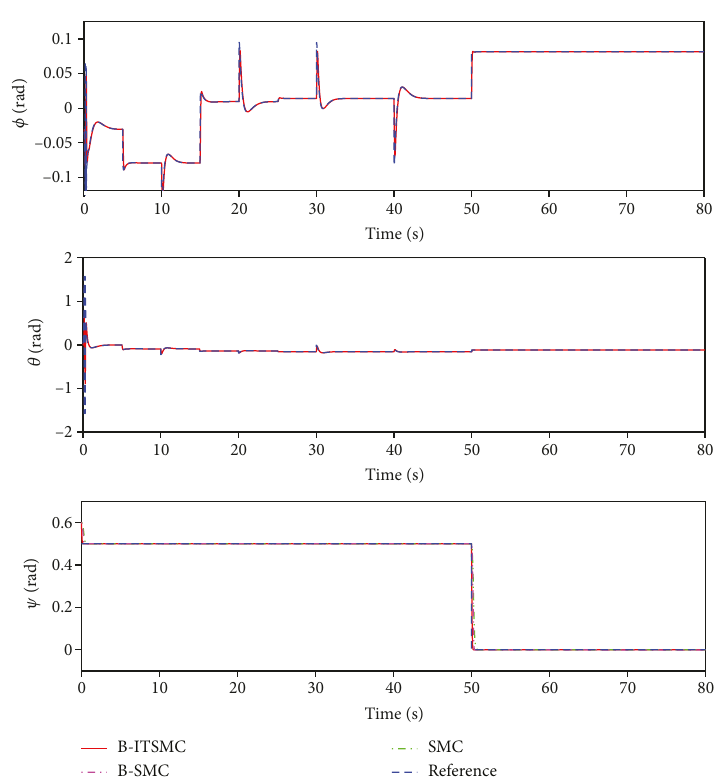
Figure 4: Response of quadrotor